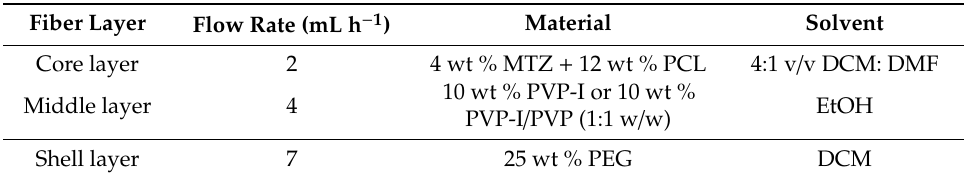
Table 1. Solution composition and corresponding flow rates used in the various sections of our multiple concentric needle systems for trilayered